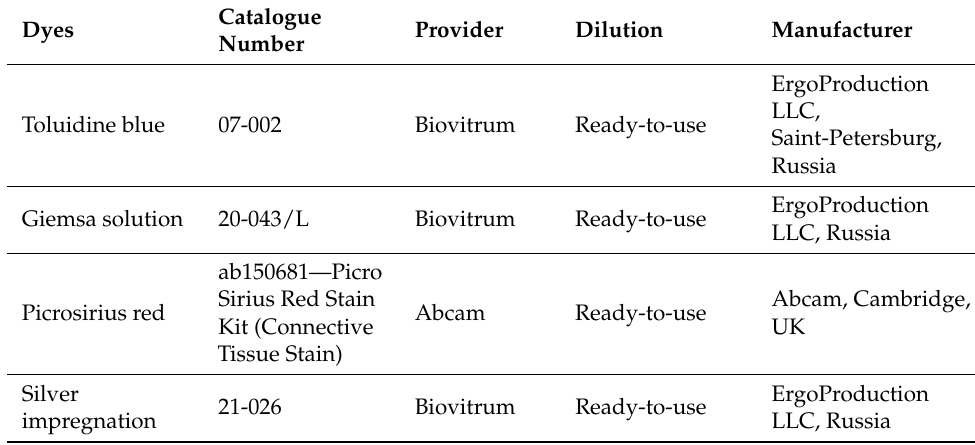
Table 3. Reagents used for histochemical staining of mouse skin.